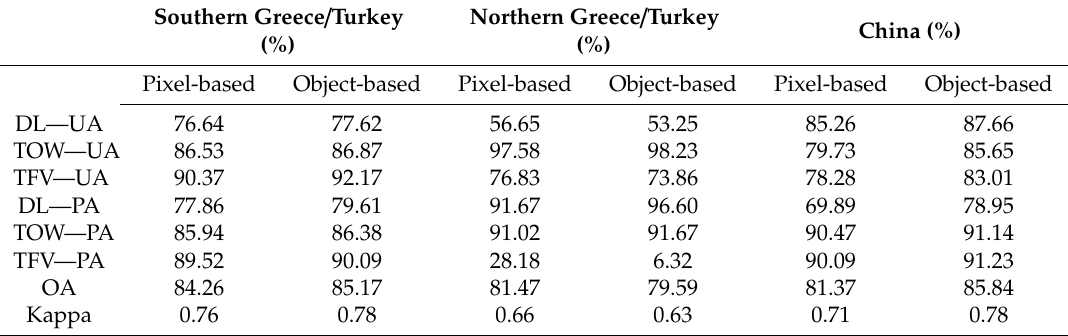
Table 6. Accuracy assessment for the pixel- and object-based classification for the individual study areas. Overall accuracy (OA) in %, Producer accuracy (PA) in %, User accuracy (UA) in %, and Kappa index